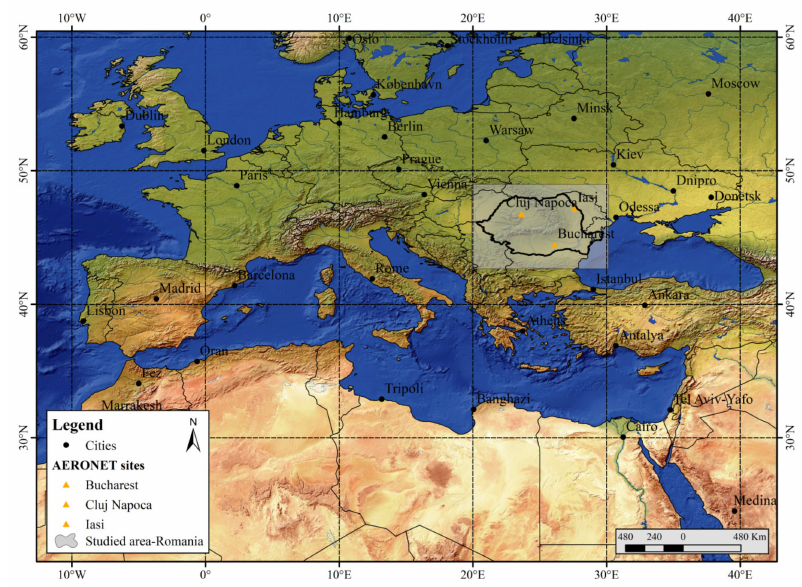
Figure 1. Study area domain with the focus region including Romania and the AERONET